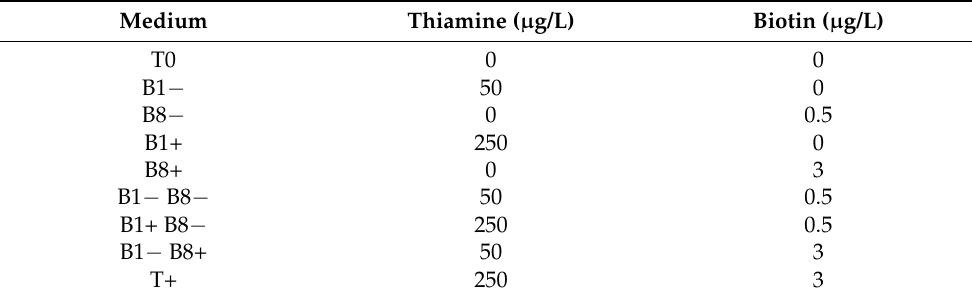
Table 1. Thiamine and biotin contents of the modified MS300 synthetic